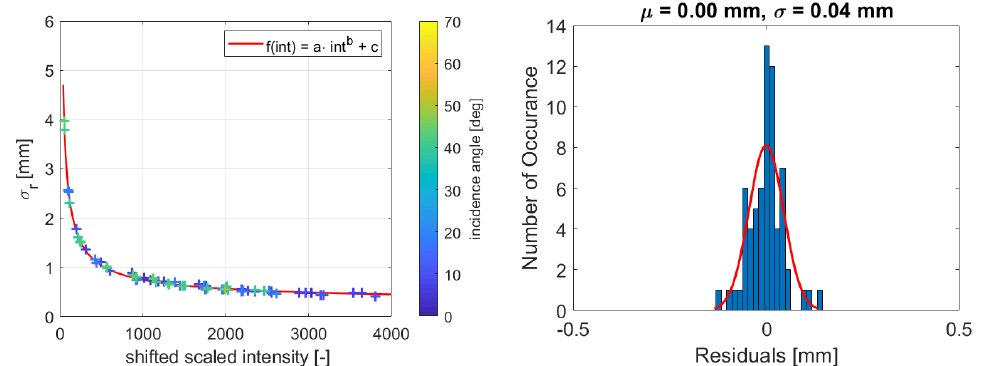
Figure 9. Left : Estimated function for Leica HDS6100 with a scan rate of 508 kHz; Right : Corresponding histogram of the residuals of the function.